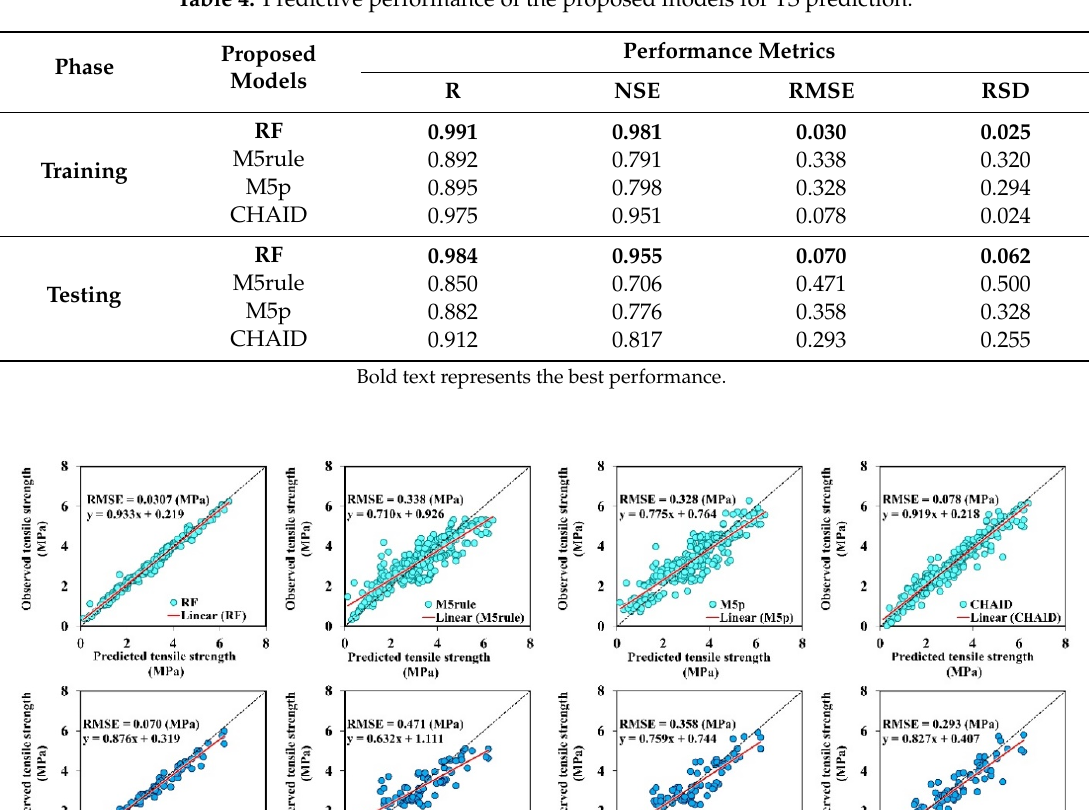
Table 4. Predictive performance of the proposed models for TS prediction.